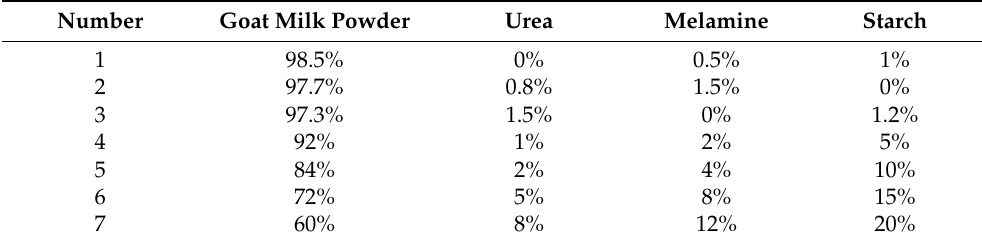
Table 1. The proportioning of goat milk powder with multiple